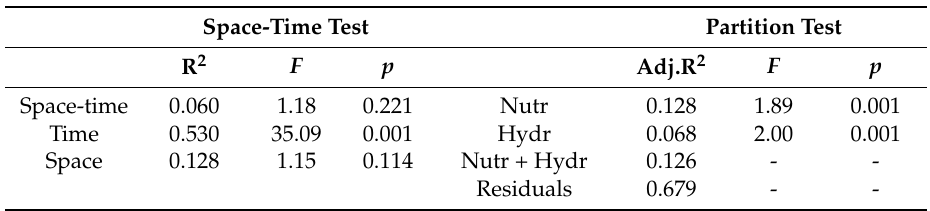
Table 2. Results of the space-time interaction test (STI) and pRDA tests. Space-time interaction (Space + Time), common temporal structures (Time), common spatial structure (Space), variation due to nutrients (Nutr), variations due to nutrients and hydrology together (Nutr + Hydr), variations due to hydrology (Hydr), not-explanable variation (Res), adjusted R 2 value (AdjR 2 ), significance ( p < 0.05). Space-Time Test Partition Test R 2 F p Adj.R 2 F p Space-time 0.060